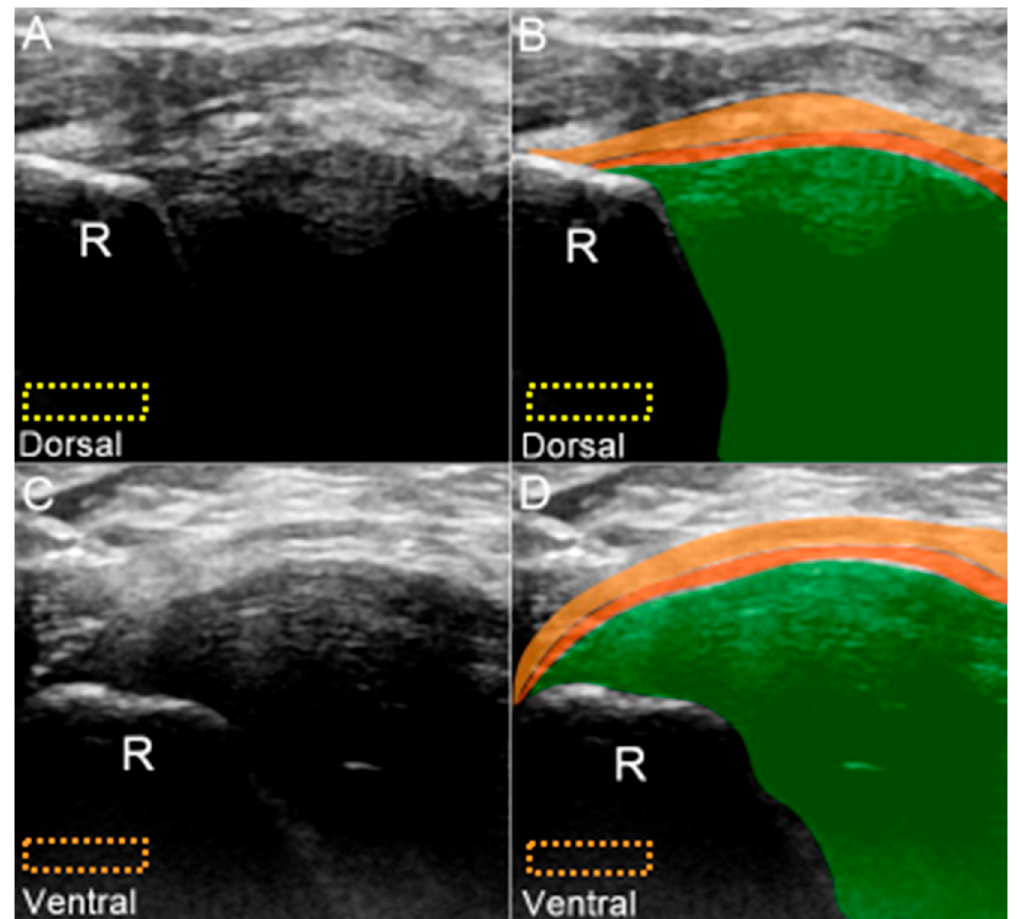
Figure 7. ( A ) US and ( B ) superposed US images of the dorsal radioulnar ligament. ( C ) US and ( D ) superposed US images of the ventral radioulnar ligament. The different color dashed rectangles are in accordance with the transducer positions in Figure 3. US: ultrasound; R: radius. Superficial limb of the radioulnar ligament (light brown shade) , deep limb of the radioulnar ligament (dark brown shade) , and articular disc (green shade) .